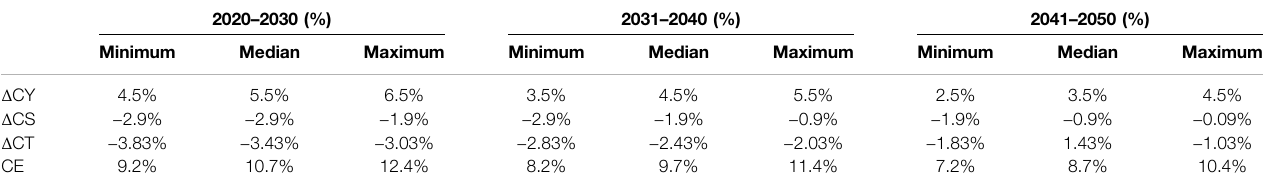
TABLE 8 | Potential change rate of each in fl uencing factor under the base scenario.